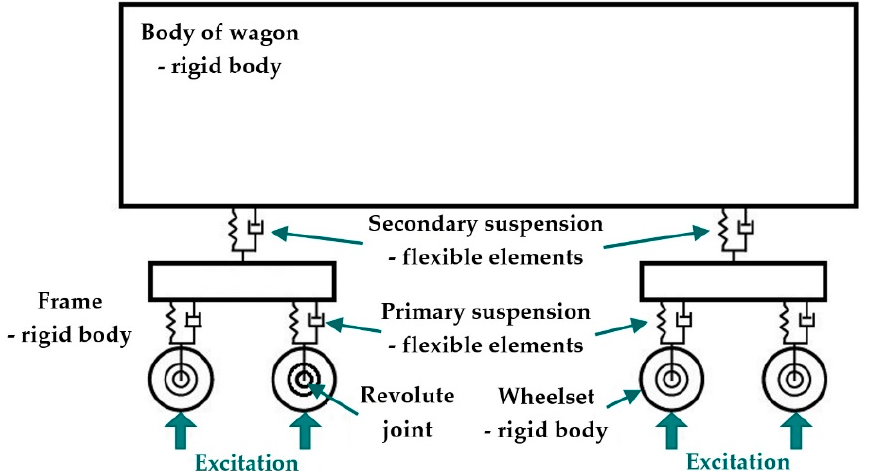
Figure 5. A scheme of the investigated railway passenger car.